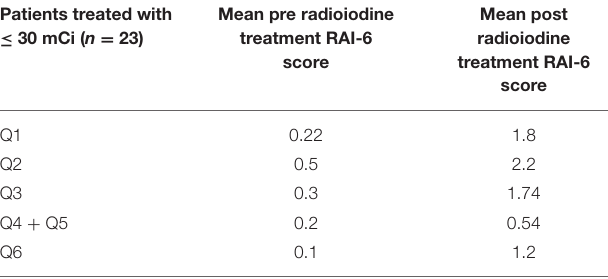
TABLE 4 | Pre- and post-operative mean RAI-6 scores in patients who received < or = 30 mCi. Patients treated with ≤ 30 mCi ( n = 23)